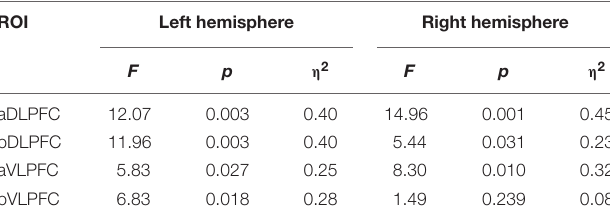
TABLE 3 | Task effects in the left and right hemisphere regions of interest (ROIs) for YAs ( (cid:49) HbR). ROI Left hemisphere Right